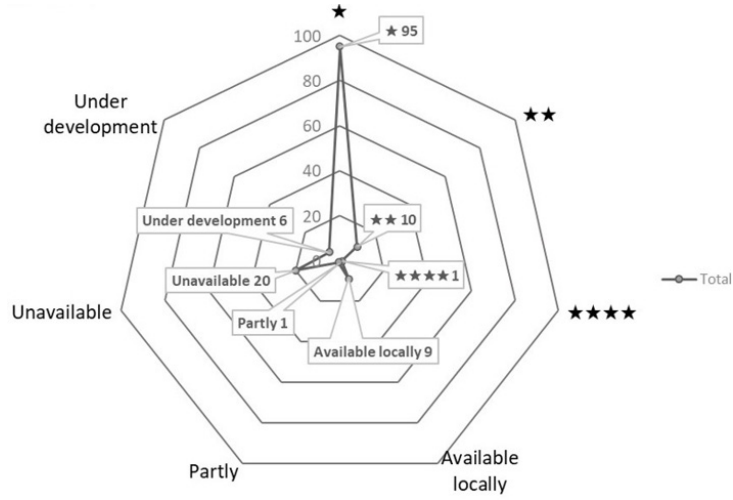
Fig. 2. Results of the quality evaluation of open geospatial data for